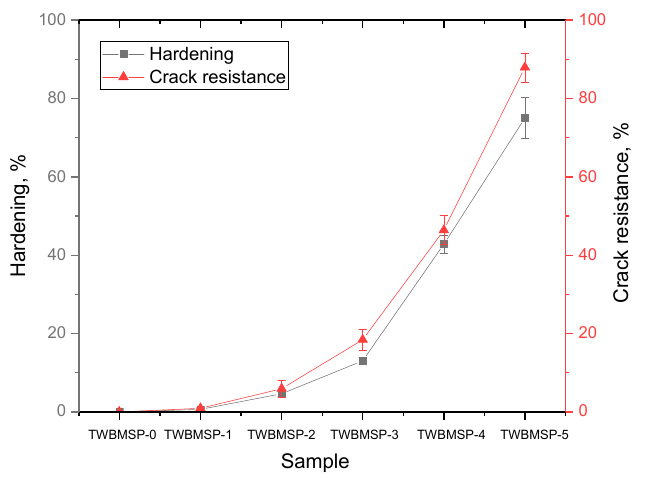
Figure 9. Results of variations in the strengthening characteristics of the synthesized ceramics.